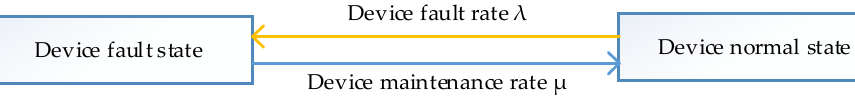
Figure 7. The state transition diagram.